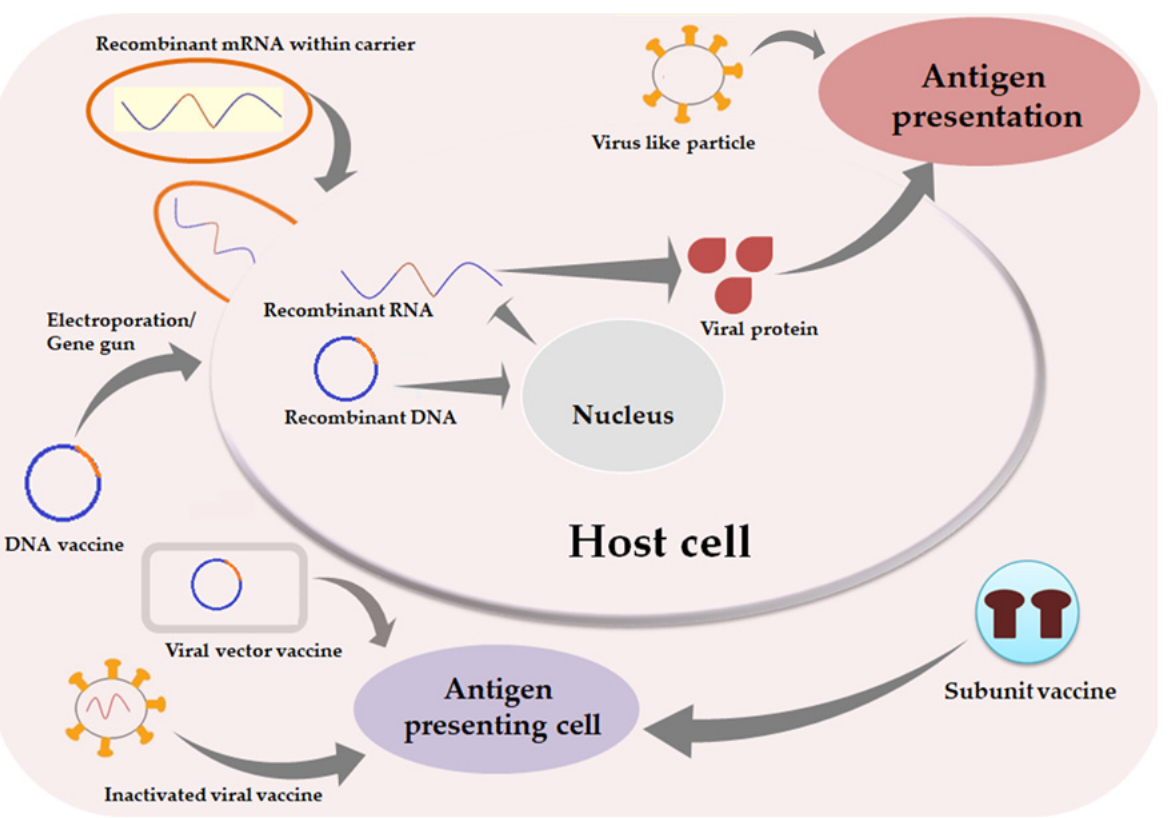
Figure 1. Strategies used in the development of common SARS ‐ CoV ‐ 2 vaccine candidates.